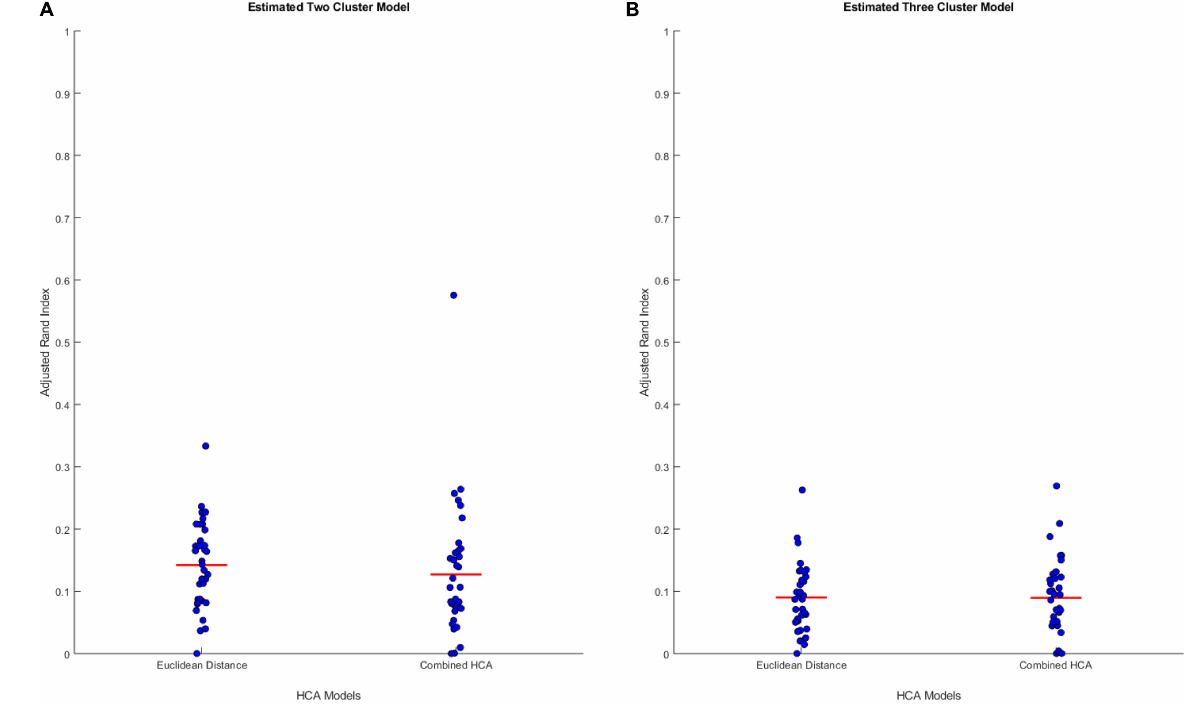
FIGURE 2 | Compares the combined HCA model to the Euclidean distance model in two predicted distributions. Each dataset was produced using mvnrnd . The accuracy of each model was assessed using the adjusted rand index (ARI). Means and covariance matrix for each dataset are shown in Supplementary Tables S2 , S3 . Red horizontal lines indicate means for each model. Stars (*) indicate statistical significance between groups using an independent samples t -test ( p < 0.05). (A) Shows estimated two cluster model, and (B) shows estimated three cluster